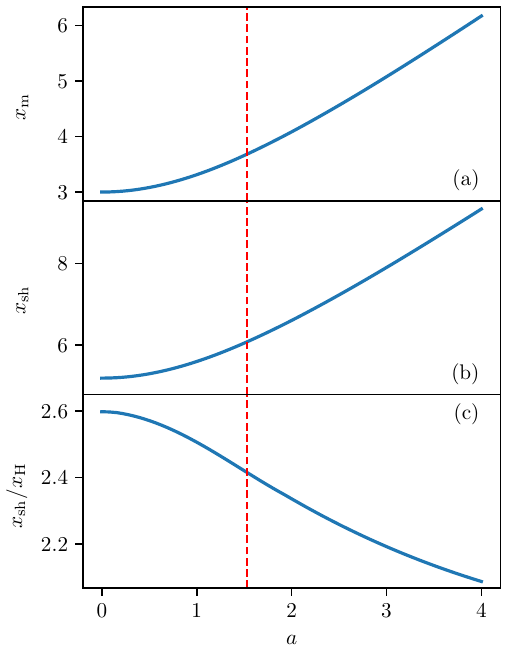
Fig. 3 From top to bottom, it shows the (dimensionless) radii of the photon sphere x m , the shadow x sh and their ratio for the quantum deformed Schwarzschild black hole with respect to the quantum defor- mation a . The red dashed line marks the upper bound on a given by the EHT